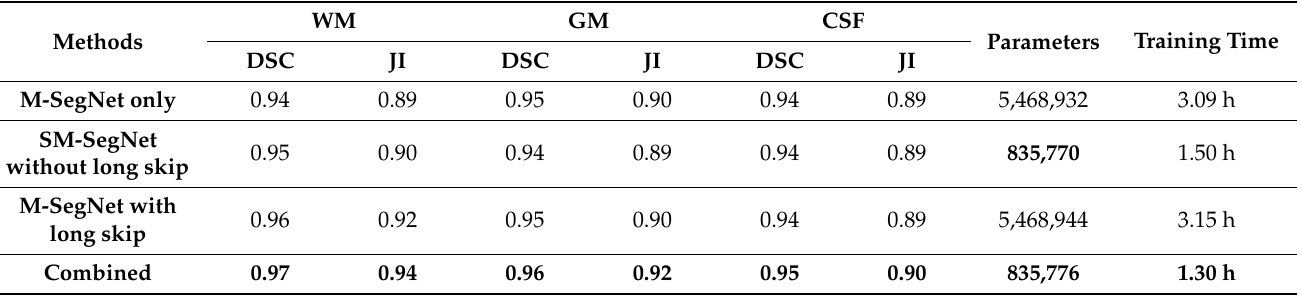
Table 3. Performance comparison between the simplified proposed models using axial plane for the OASIS